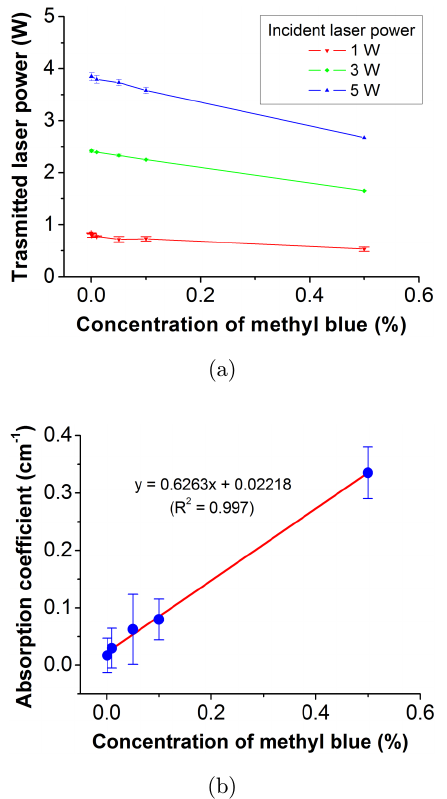
Fig. 7. (a) Transmitted laser power varied with di®erent concentrations of methyl blue at 3 incident laser powers (1, 3 and 5 W). (b) The absorption coe±cients of the methyl blue solution determined by the Beer-Lambert law at di®erent concentrations.